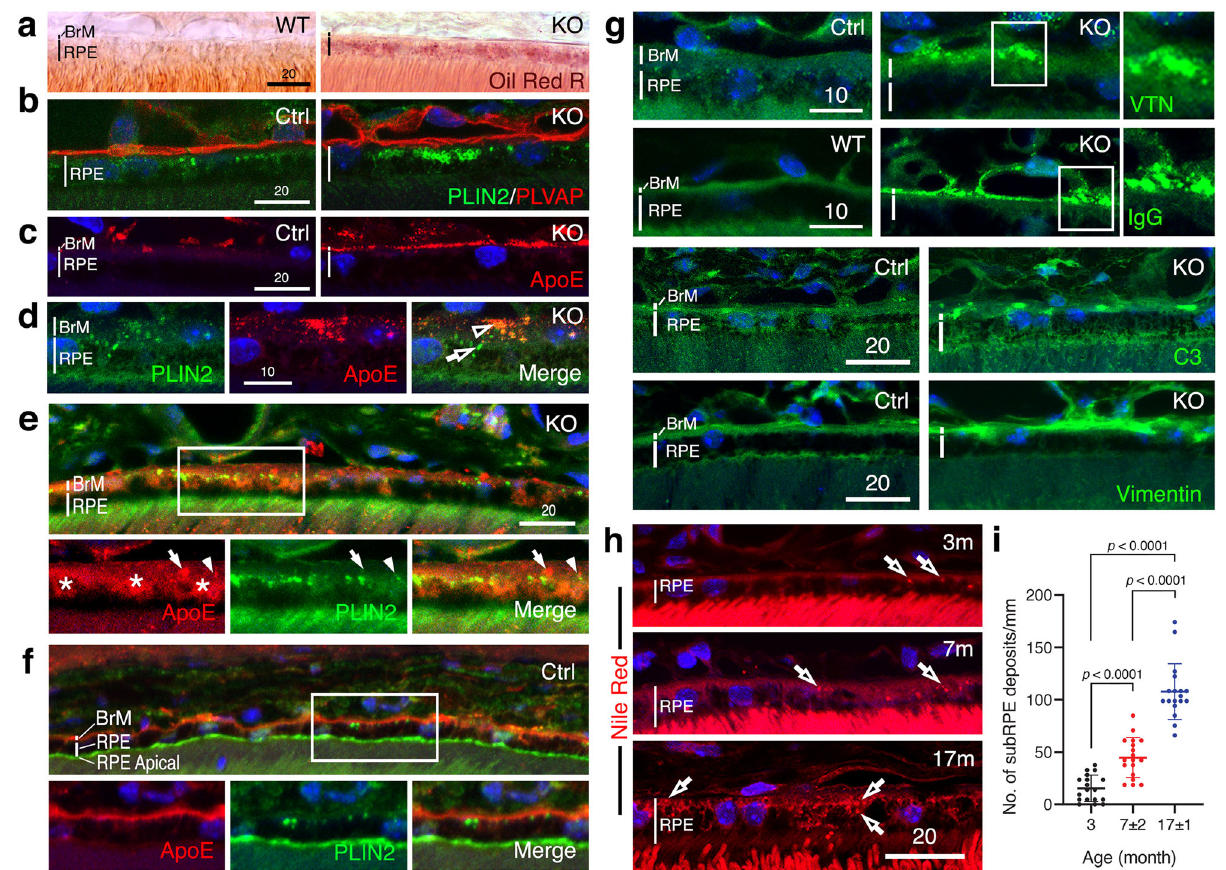
Fig. 5 RPE Δ Clic4 mice have aberrant and age-related lipids, lipoproteins, and protein depositions at sub-RPE/BrM. a – d In 6-8-month-old Ctrl and KO mice, the retina-RPE-choroid complex was stained with lipid dyes ( a ) or antibodies plus DAPI ( b – d ). a shows Oil Red O staining of RPE-expressed LDs and some BrM areas in a prebleached retina slice. d BrM-expressed PLIN2 (arrows) and overlapping ApoE (arrowhead) in a KO mouse retinal slice sectioned tangentially across the RPE-choroid complex. e , f The RPE-BrM regions of the ~18-month-old KO ( e ) and Ctrl ( f ) mice stained for PLIN2 and ApoE. Bottom panels are the enlarged, boxed areas of the top panels. In ( e ), arrowheads point to the colocalized ApoE and PLIN2; arrows point to the aggregated ApoE signals (arrows); asterisks marked the ApoE-rich sub-RPE deposits. g The RPE-BrM region of 10 – 18-month-old KO (right panels) and Ctrl or WT (left panels) mice stained for the indicated drusen markers. VTN vitronectin, IgG Immunoglobulin. The enlarged boxed areas highlight the aggregated staining pattern of the indicated proteins. a – g are representative images of three independent experiments. h Representative images show the age-dependent increase of Nile Red- stained granular lipid deposits in the basal/sub-RPE regions (open arrows) in the KO mice. i Quanti fi cation of the sub-RPE granular lipid deposits shown in ( h ). Mean± SD (18 surveyed areas over N = 3 mice) are shown. Two-tailed Student t -test. Scale bar in μ m. Source data of ( i ) are provided as a Source Data fi